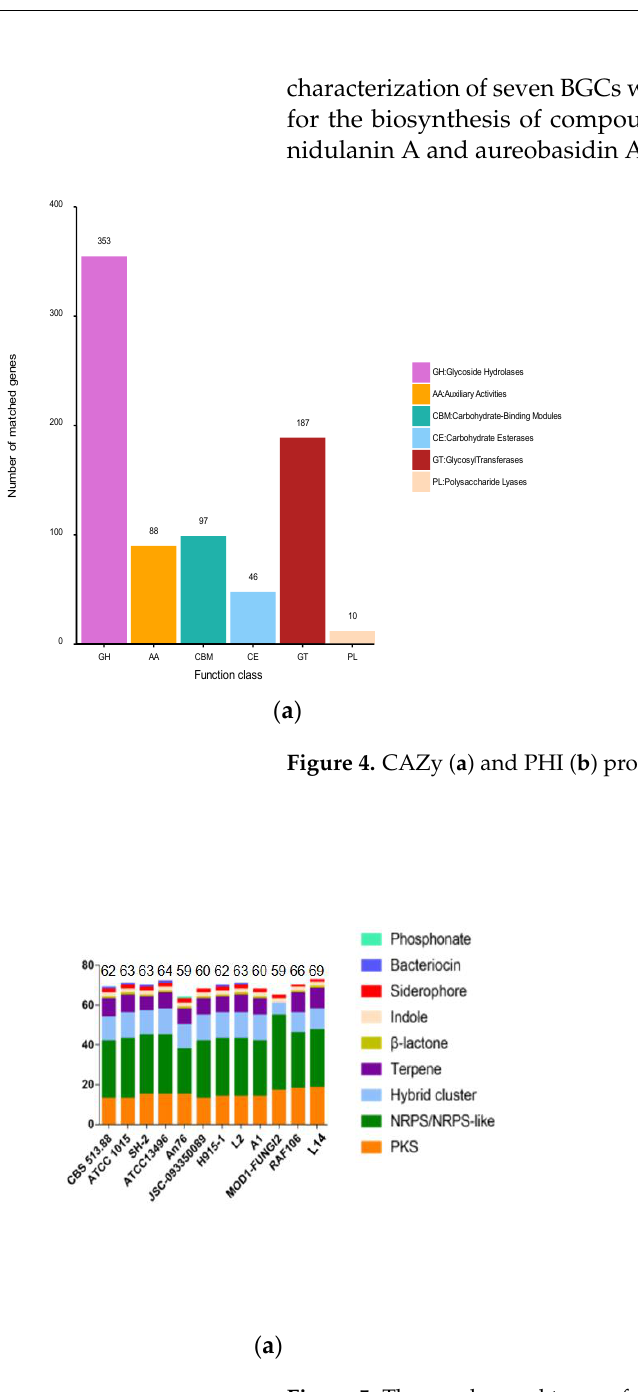
Figure 5. The number and types of secondary metabolite BGCs ( a ) and their putative products ( b ) in strain L14 and other A. niger strains deposited in antiSMASH